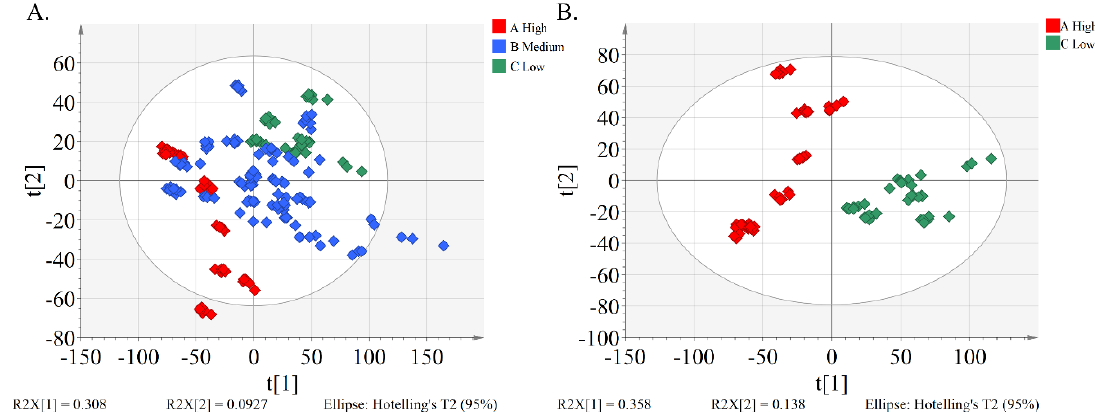
Figure 2. Multivariate statistical analysis of peach samples based on an unsupervised PCA model. ( A ) Unsupervised PCA plot of non-targeted metabolites analyzed by UPLC-Q-TOF/MS of 33 cultivars of peach pulp extract; ( B ) unsupervised PCA plot of two groups A (IC 50 < 15, High) and C (IC 50 ≥ 25, Low), which were clearly separated. Information on sample ID and IC 50 range of groups is given in